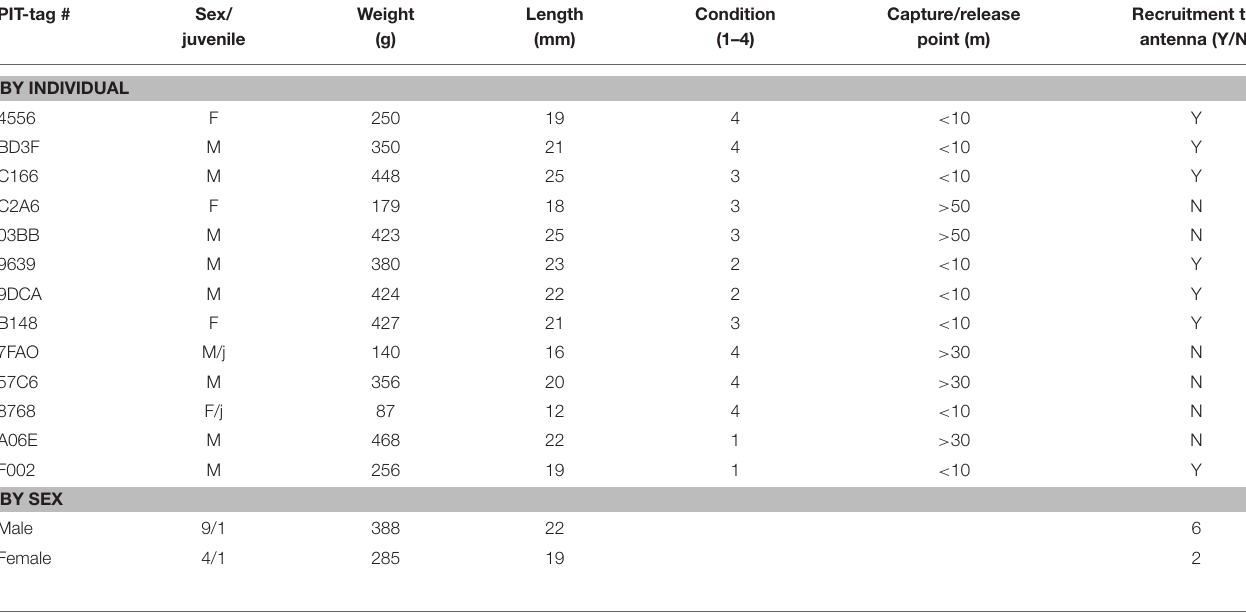
TABLE 2 | Recruitment to RFID antenna for wild Norway rats, Rattus norvegicus , captured on Eastern Long Island and monitored from January 2014–May 2015. Rat Total visits Days visited/ Proportion days Average visits Total dwelling Average dwelling t; P visits total days visited BY INDIVIDUAL